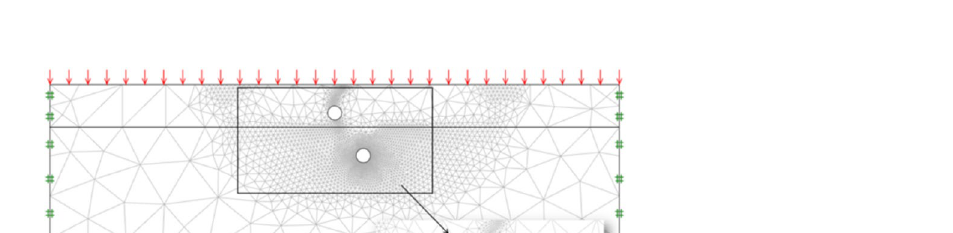
Figure 1. Problem definition.